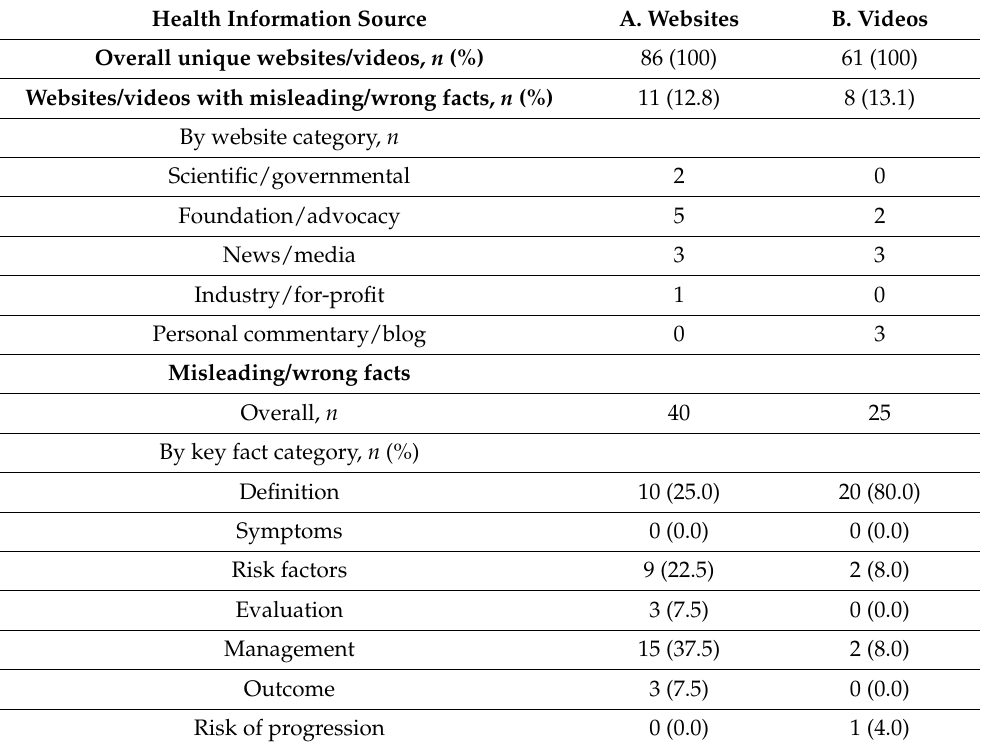
Table 3. Misleading and wrong facts on websites and